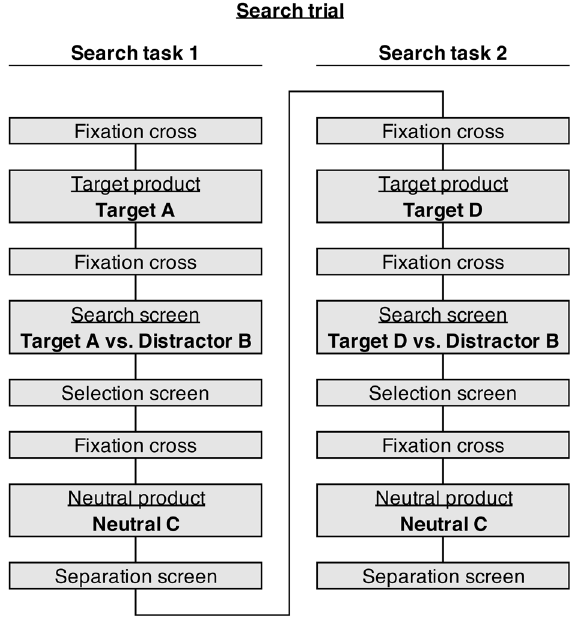
Figure 4. Trial structure (Experiment 2). Conceptual overview of the trial structure of one search trial in the exposure phase of Experiment 2. One trial consists of two search tasks (Search Task 1 and Search Task